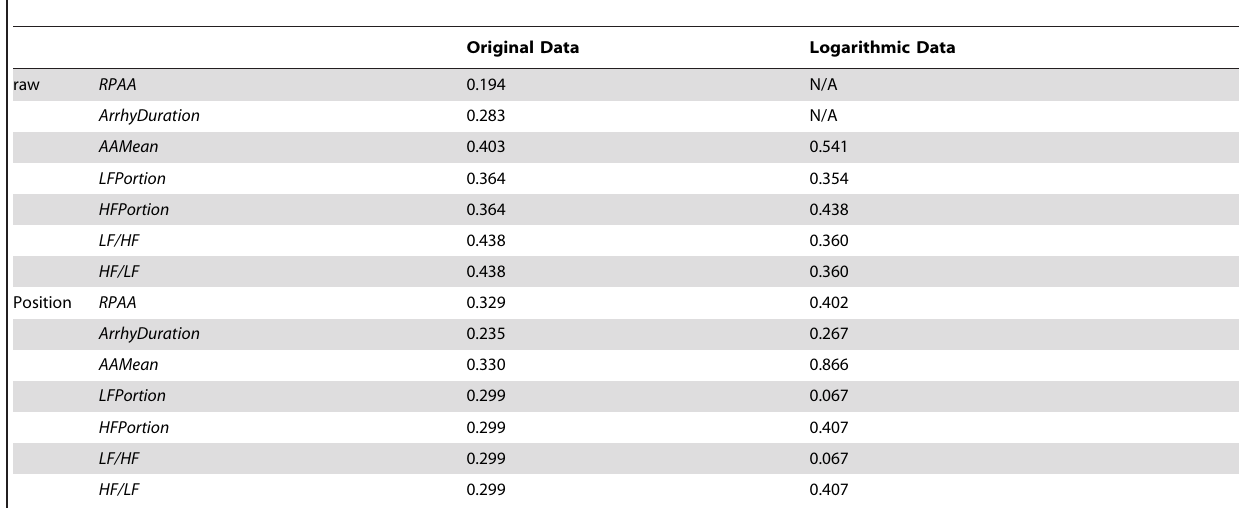
Table 4. ANOVA analysis of time effect of the Non-AF patient variables data, which were significant in 2-pre AF hours in AF patient